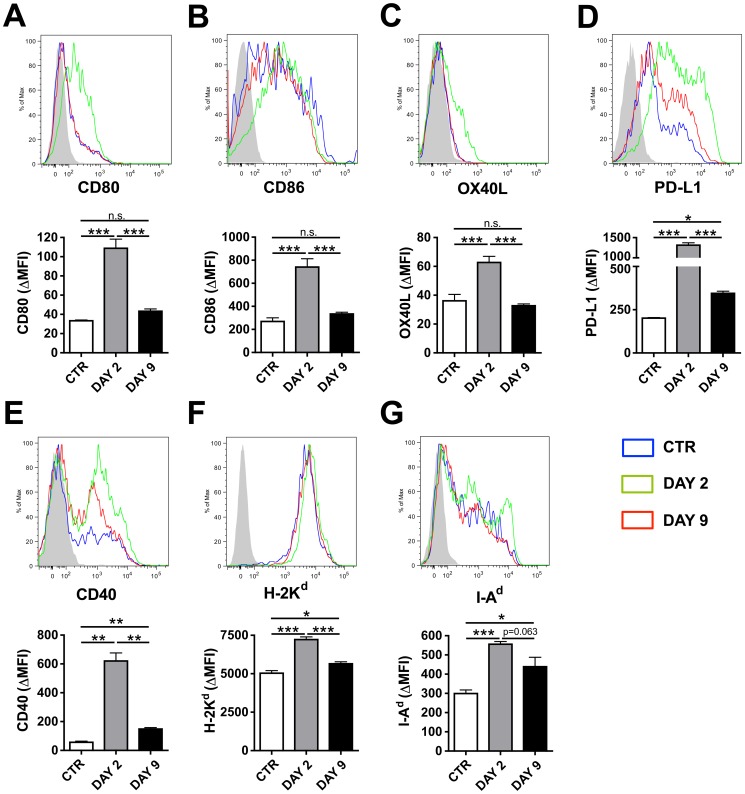
DCs in LNs draining CHS-inflamed skin in WT mice display changes in their expression of co-stimulatory and MHC molecules.FACS analysis was performed on CD11c+ DCs present in auricular LNs draining DAY 2- and DAY 9-inflamed or uninflamed control (CTR) skin of WT mice. (A–G) Analysis of the expression levels of co-stimulatory and MHC molecules. The upper panel shows representative FACS plots. Blue line: CTR; green line: DAY 2; red line: Day 9; filled histogram: isotype control. To reduce complexity, only one out of three similar isotype control stainings is shown. The lower graph shows the Δ MFI (defined as the MFI of the specific staining – the MFI of the isotype control staining) values measured for each condition (n = 3-4 mice/group). (A) CD80, (B) CD86, (C) OX40L, (D) PD-L1, (E) CD40, (F) H-2Kd and (G) I-Ad. Representative data from 1 out of 2 similar experiments are shown. *p<0.05; **p<0.01; ***p<0.001.